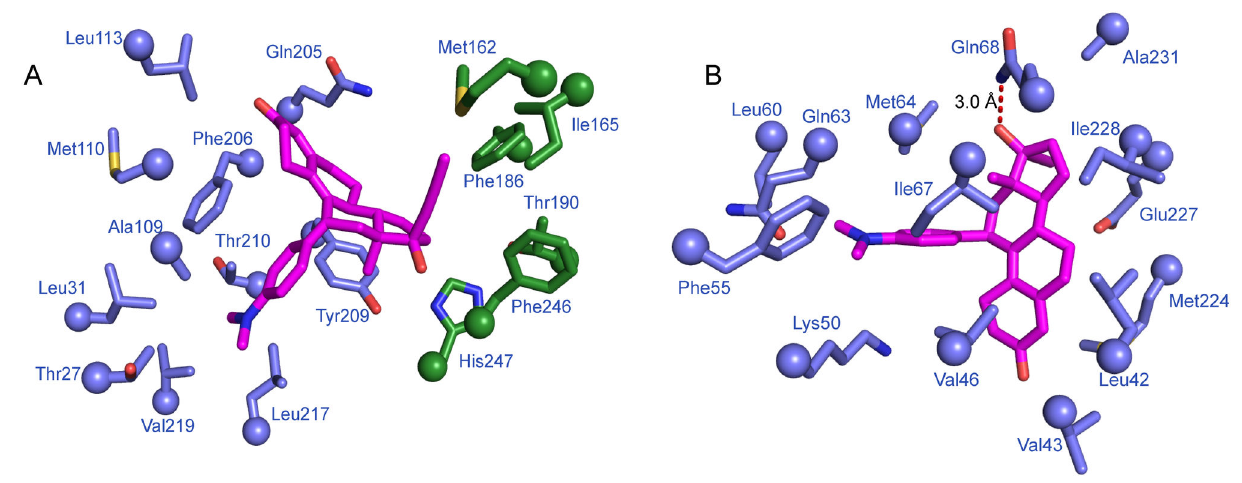
Figure 4. Mifepristone binding site interactions. ancSR2 is shown in slate blue; mifepristone is shown in magenta (oxygens, red; nitrogens, blue). Residues within 4.2 Å of the ligand are shown. A. Site-one mifepristone interacts with both the monomer in the asymmetric unit as well as residues in a symmetry mate (forest green). B. Site-two mifepristone interacts with residues in the ancSR2 coactivator